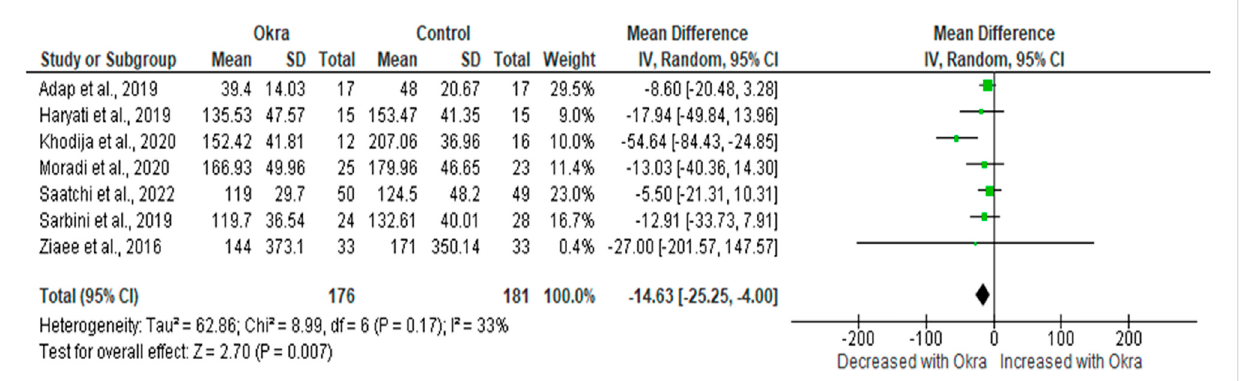
FIGURE 2 The effect of okra treatment on fasting blood glucose in type 2 diabetic patients. Results presented as mean difference, 95% con fi dence intervals. A p -value of 5% or less is considered statistically signi fi